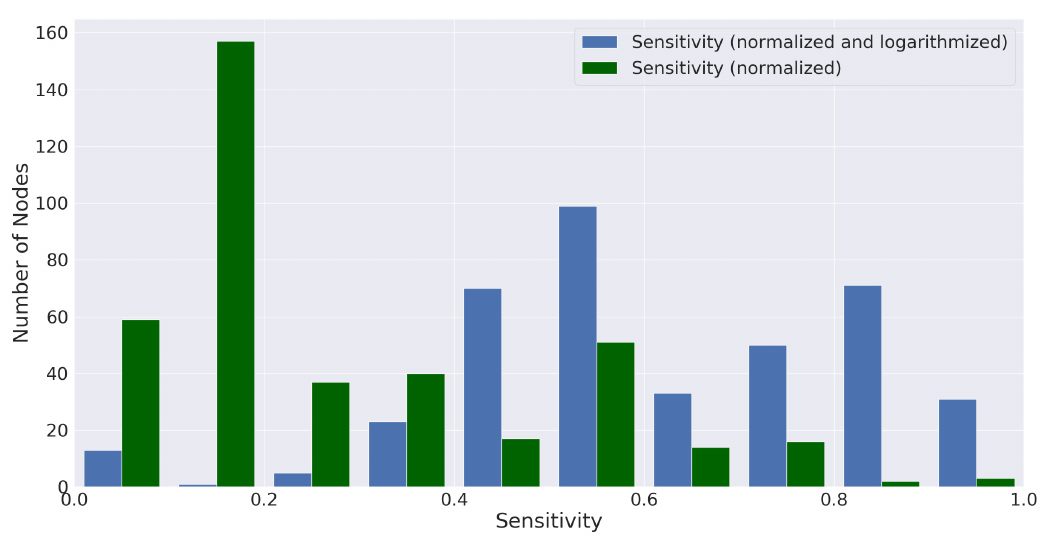
Figure 3. Histogram of normalized respectively logarithmized and normalized node